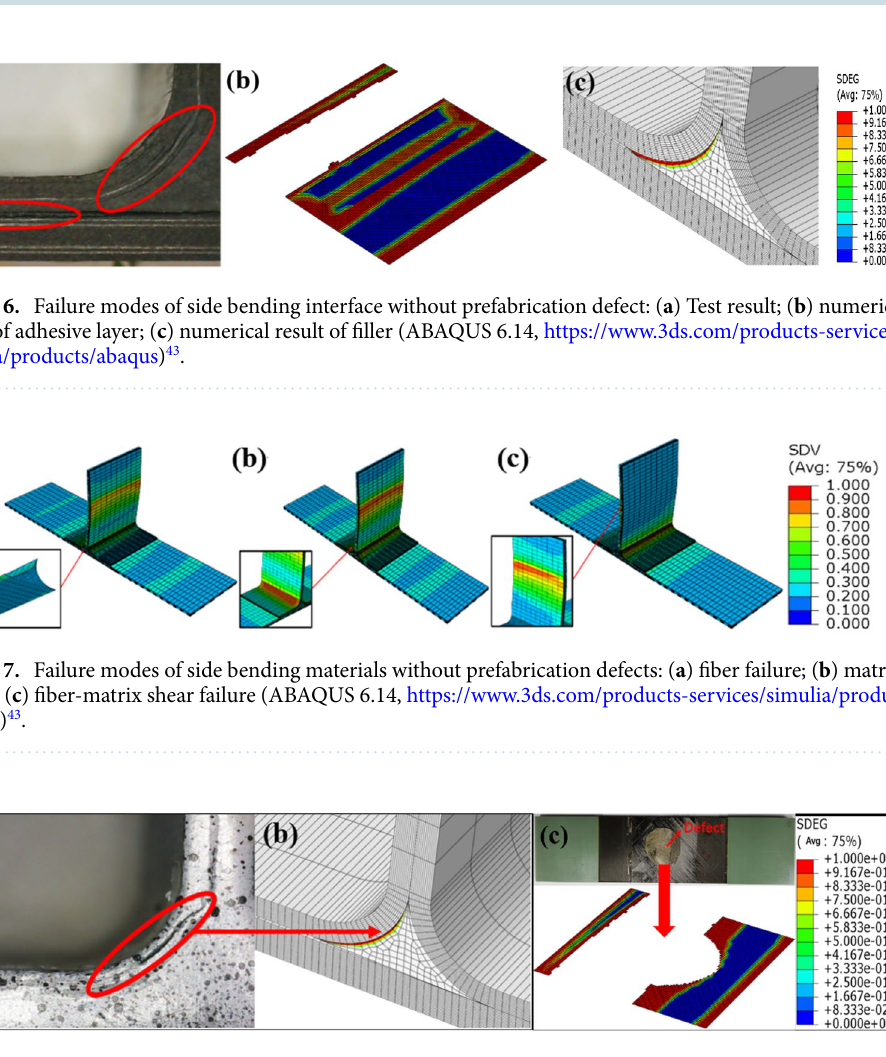
Figure 8. Failure modes of side bending interface with defect: ( a ) failure mode of test with defect; ( b ) interface layer failure 1; ( c ) interface layer failure 2 (ABAQUS 6.14, https:// www. 3ds. com/ produ cts- servi ces/ simul ia/ produ cts/ abaqus) 43